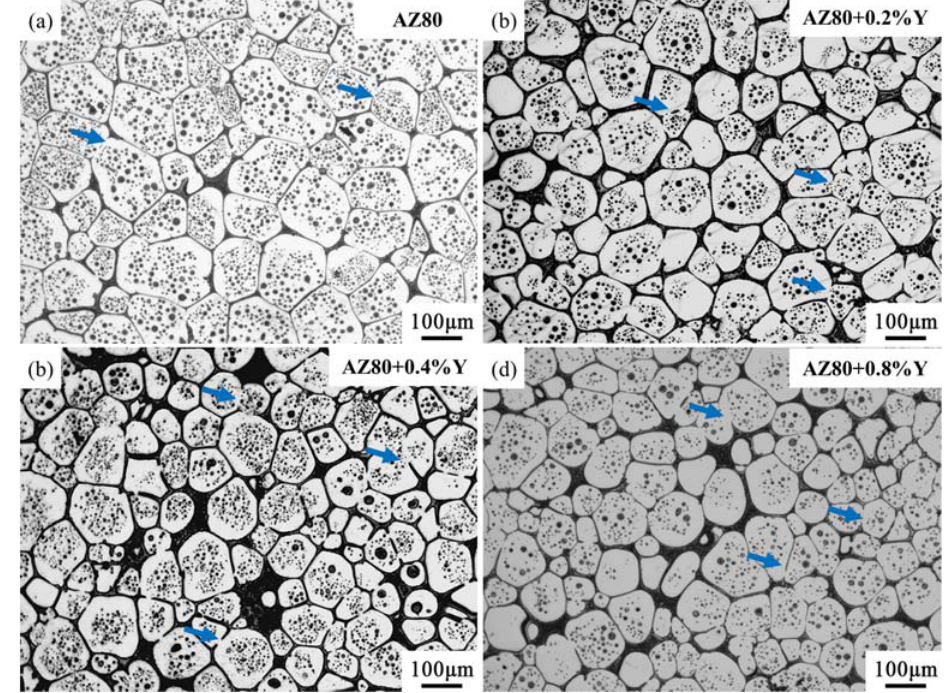
Figure 6. Microstructure evolution of alloys isothermally treated at 570 ◦ C holding for 20 min: ( a ) AZ80; ( b ) AZ80M1; ( c ) AZ80M2; and ( d ) AZ80M3.